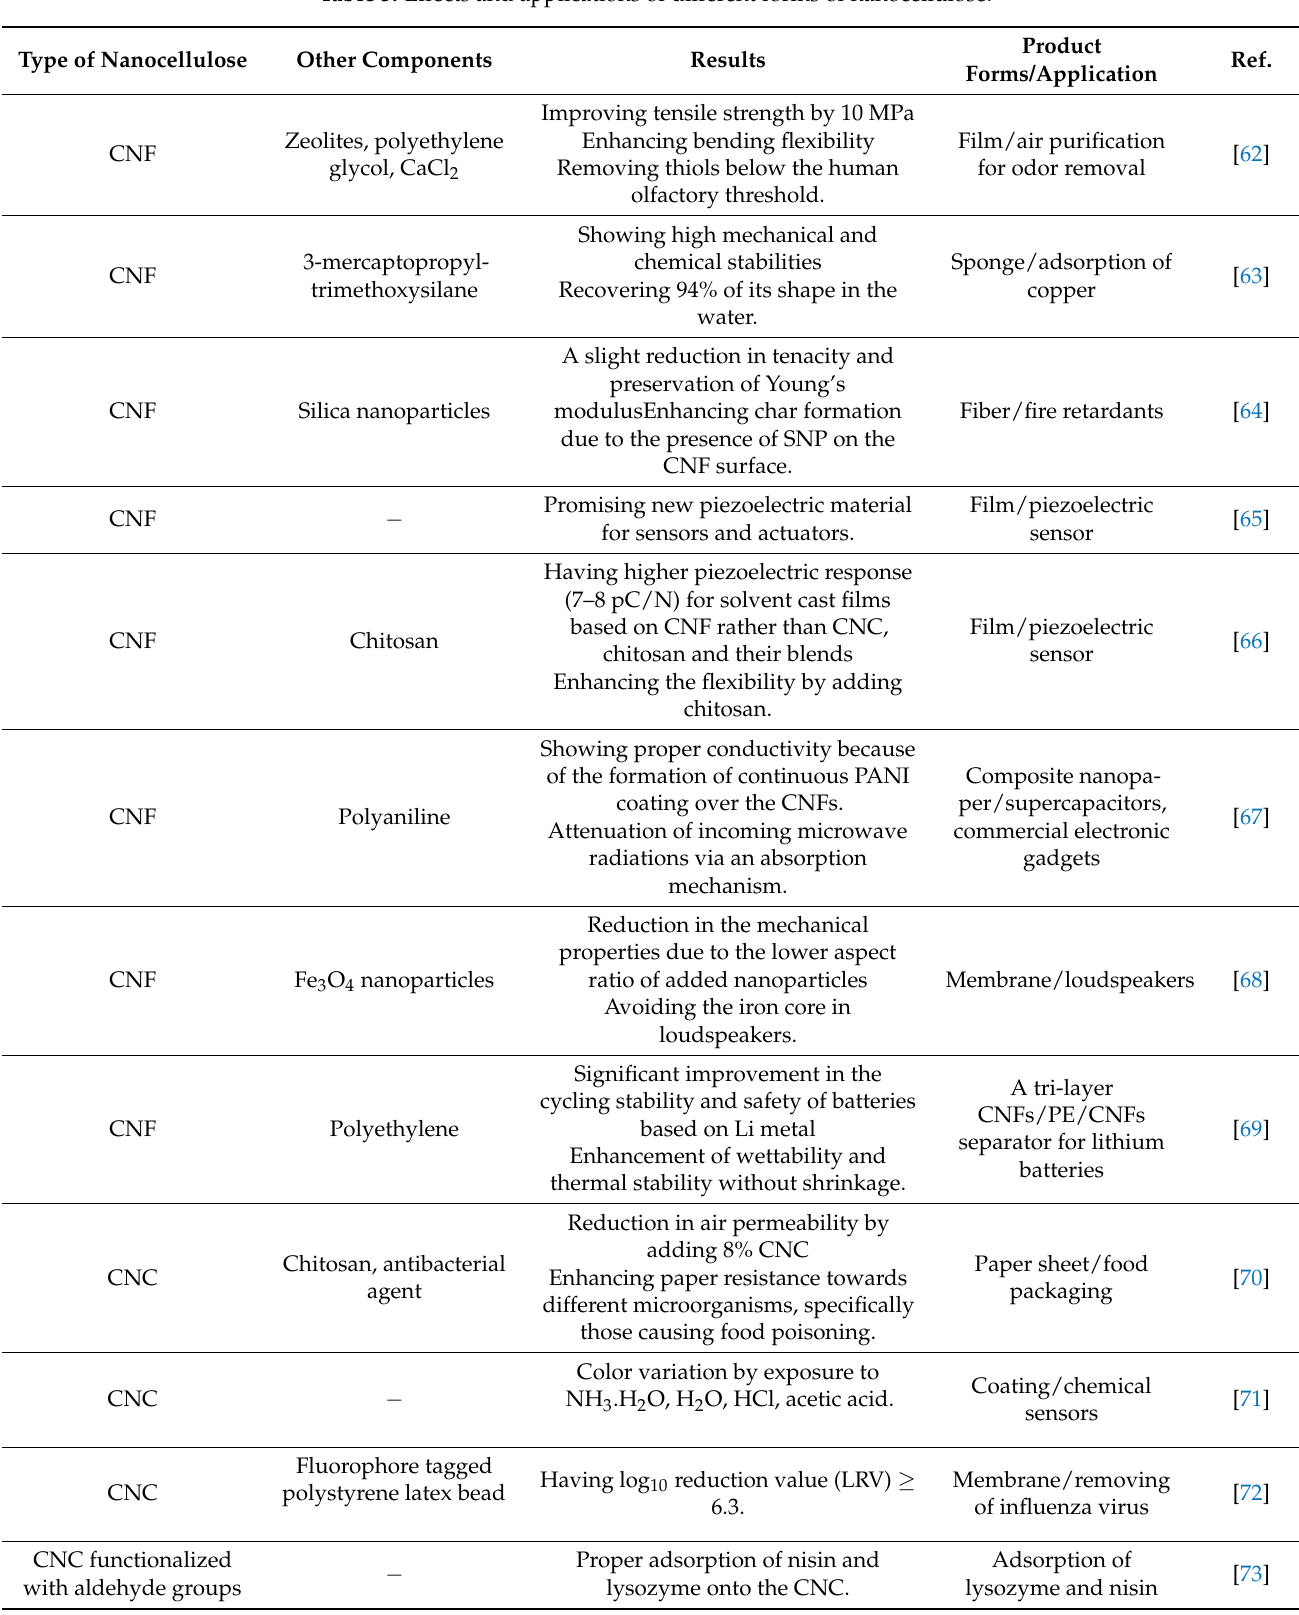
Table 3. Effects and applications of different forms of